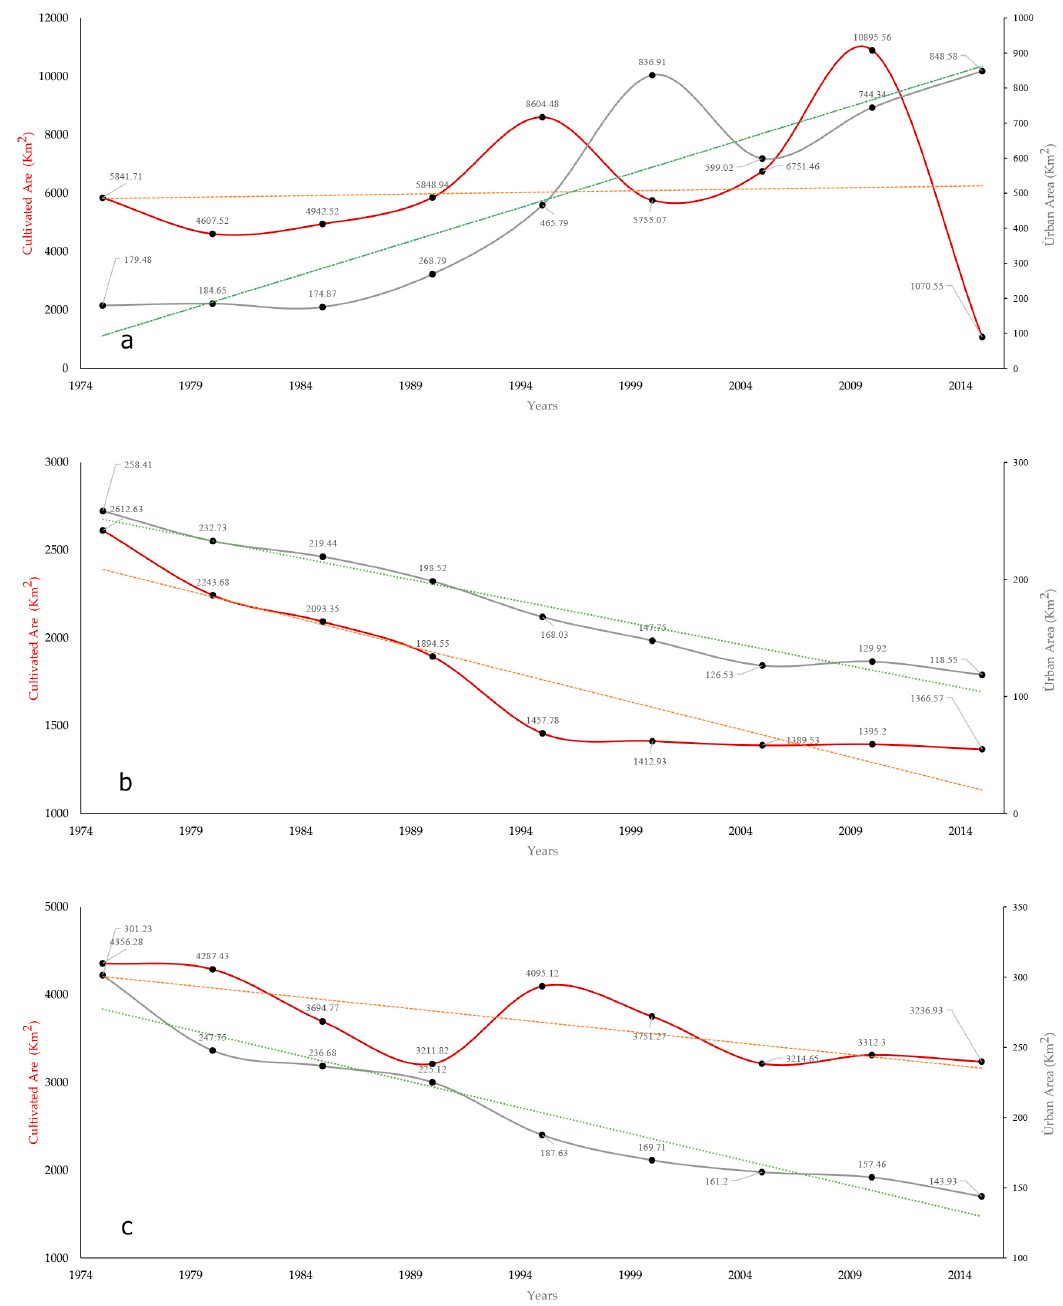
Figure 8. Temporal land use changes (every five years) in the period 1975–2015 for: ( a ) Urmia Lake basin; ( b ) Lake Sevan basin; and ( c ) Van Lake basin.